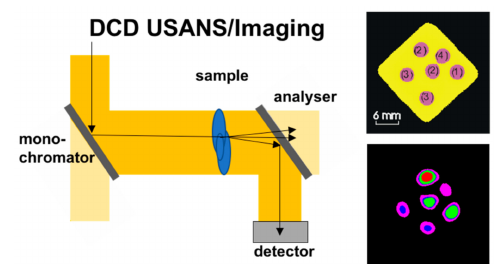
Figure 2. Double crystal diffractometer for imaging ( Left ) and results ( Right ) of differential phase (matrix, Top ) and dark-field contrast ( Bottom ) tomographies of a reference sample filled with different sizes and concentrations of beta-carotine particles in solution as visualized in the tomography (color code); Results Reproduced from [10], with the permission of AIP